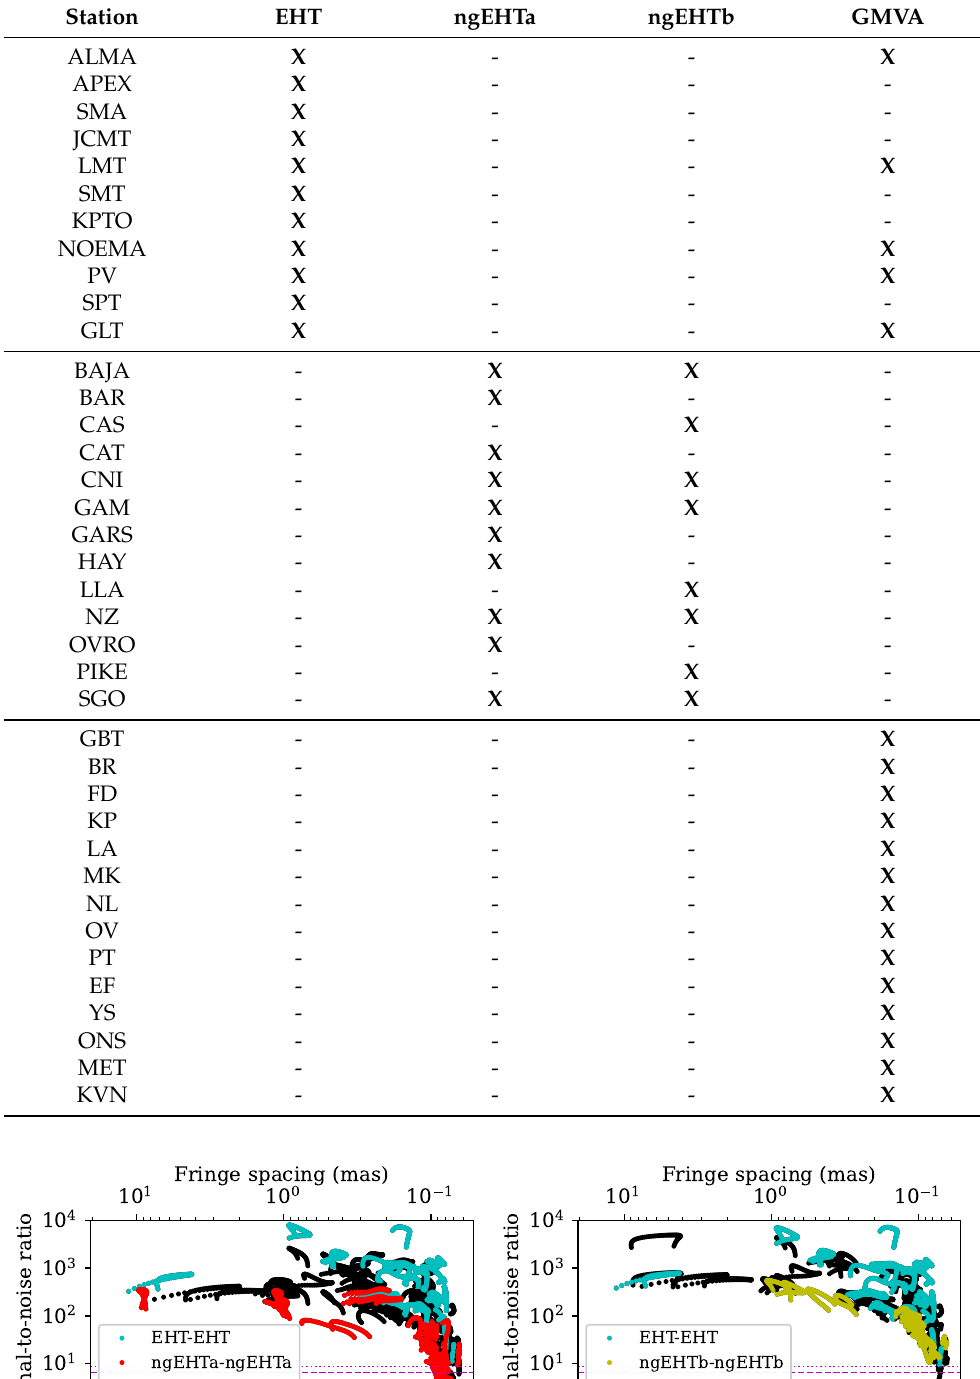
Table 1. Station participation in current and future VLBI arrays.